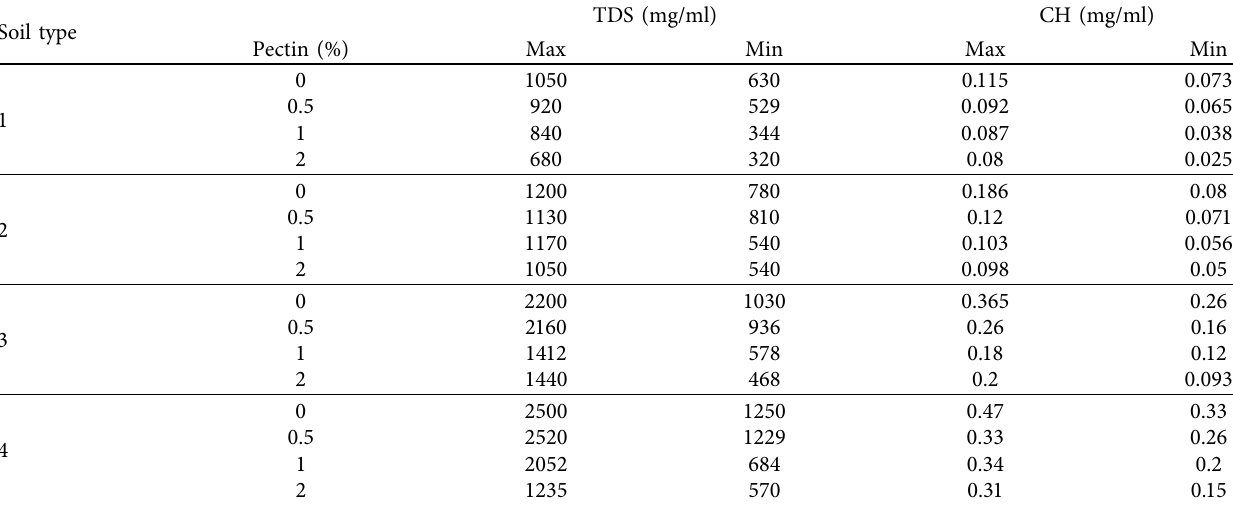
Table 4: Te chemical composition of soil before and after